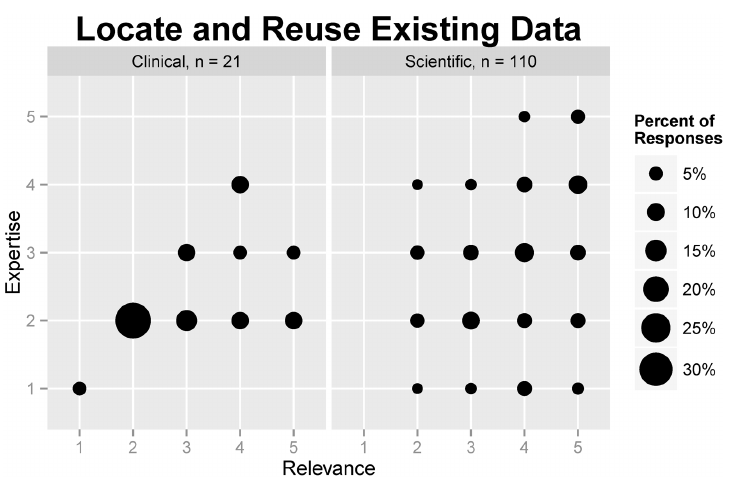
Fig 1. Comparison of self-rated relevance and expertise regarding reusing data among clinical and scientific research